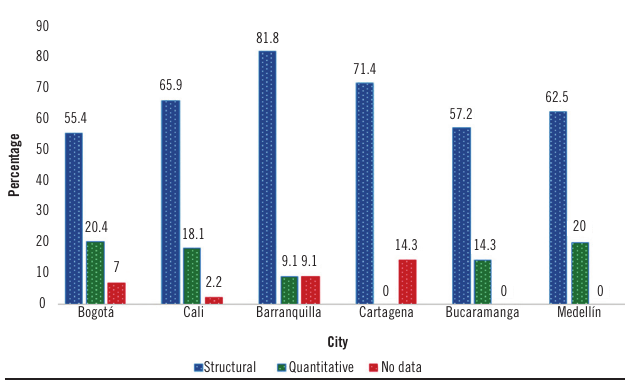
figurE 3 − Percentage distribution of hemoglobinopathies by city The included structural hemoglobinopathies are: HbS, HbC, HbSC, rapidly migrating Hb, slowly migrating Hb, and other possible variants. The included quantitative hemoglobinopathies are: elevated HbA, elevated HbA2, and elevated HbA/HbA2 simultaneously. The “no data” group included results without a clear Hb electrophoretic pattern in the first sample, and lack of a confirmatory sample. Each percentage was calculated using the total number of cases per category over the total number of subjects with a confirmatory sample.